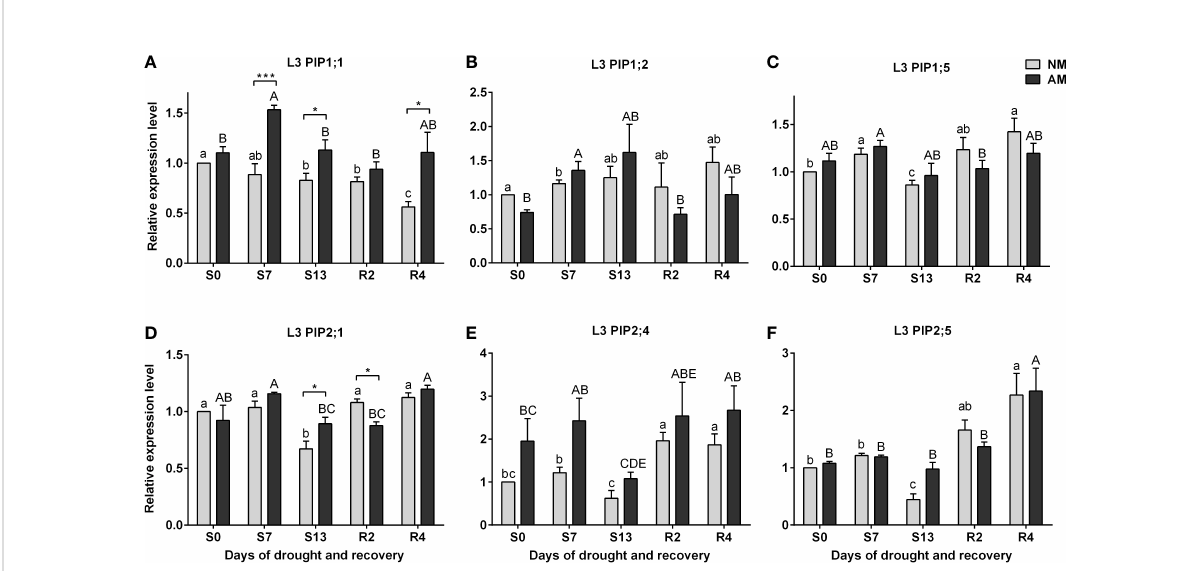
FIGURE 5 Analysis of aquaporins (A) PIP1;1 , (B) PIP1;2 , (C) PIP1;5 , (D) PIP2;1 , (E) PIP2:4 , (F) PIP2;5 transcipt accumulation in leaf 3 (L3) during the development of drought (S0-S13) and rehydration (R2, R4). The results were normalized to the expression of reference gene 18S RNA and presented as a relative to S0 time point for NM plants. The bars represent mean values (n=6) and standard error of mean of three technical replicates taken from two independent cultures as extracts from a mix of leaf strips from six plants of each symbiotic variant. The asterisks show statistically signi fi cant differences between NM and AM calculated using Student ’ s t -test (* p <0.05, *** p <0.001). Lower-case letters show signi fi cant differences between NM means and upper-case letters signi fi cant differences between AM means in following days calculated using ANOVA test.